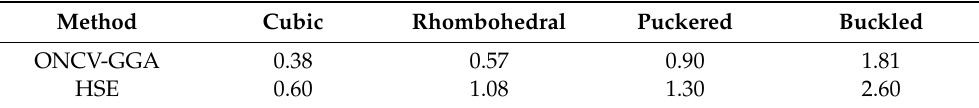
Table 2. Calculated band gaps of bulk (cubic and rhombohedral) and monolayer (puckered and buckled) GeTe using the ONCV-GGA and HSE methods. Method Cubic Rhombohedral Puckered Buckled ONCV-GGA